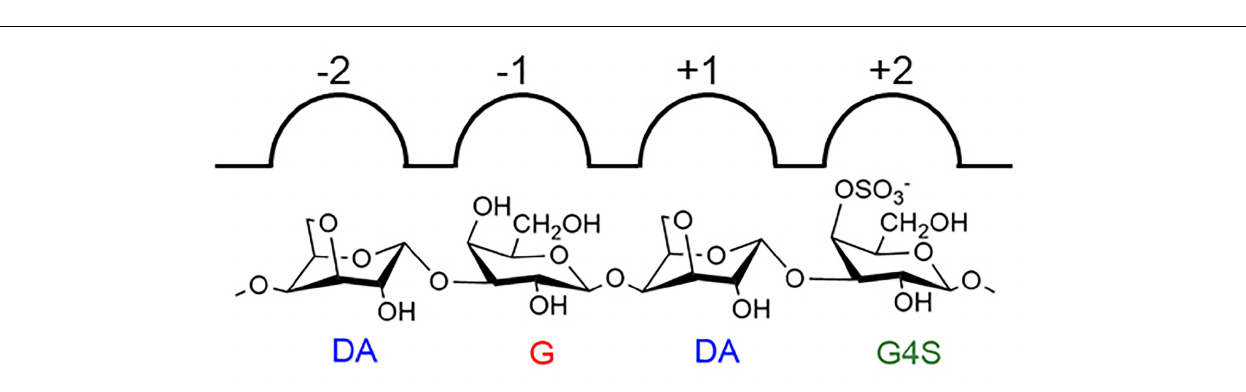
FIGURE 8 | An illustration of the specificity of